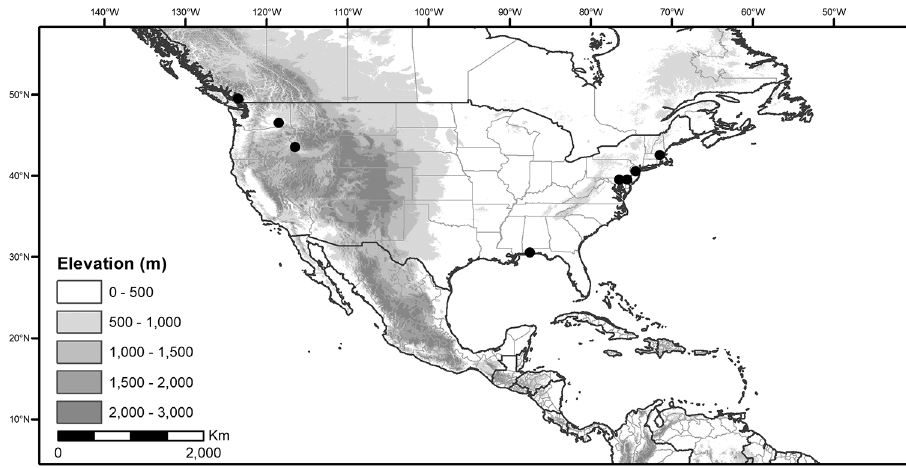
Figure 56. Distribution of Solanum villosum